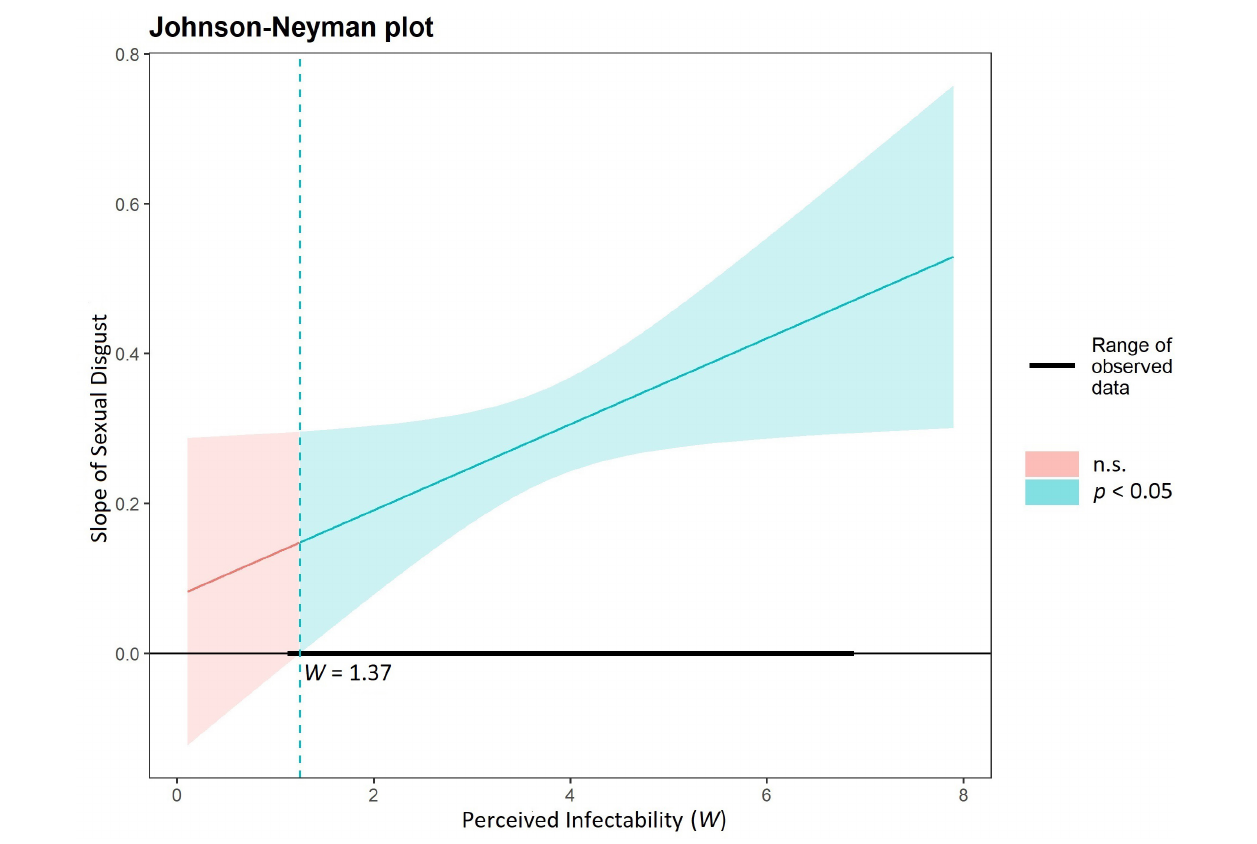
FIGURE 1 | Regions of significance for the conditional effect of sexual disgust presented for perceived infectability as a moderator and negativity toward gay men as the outcome variable.